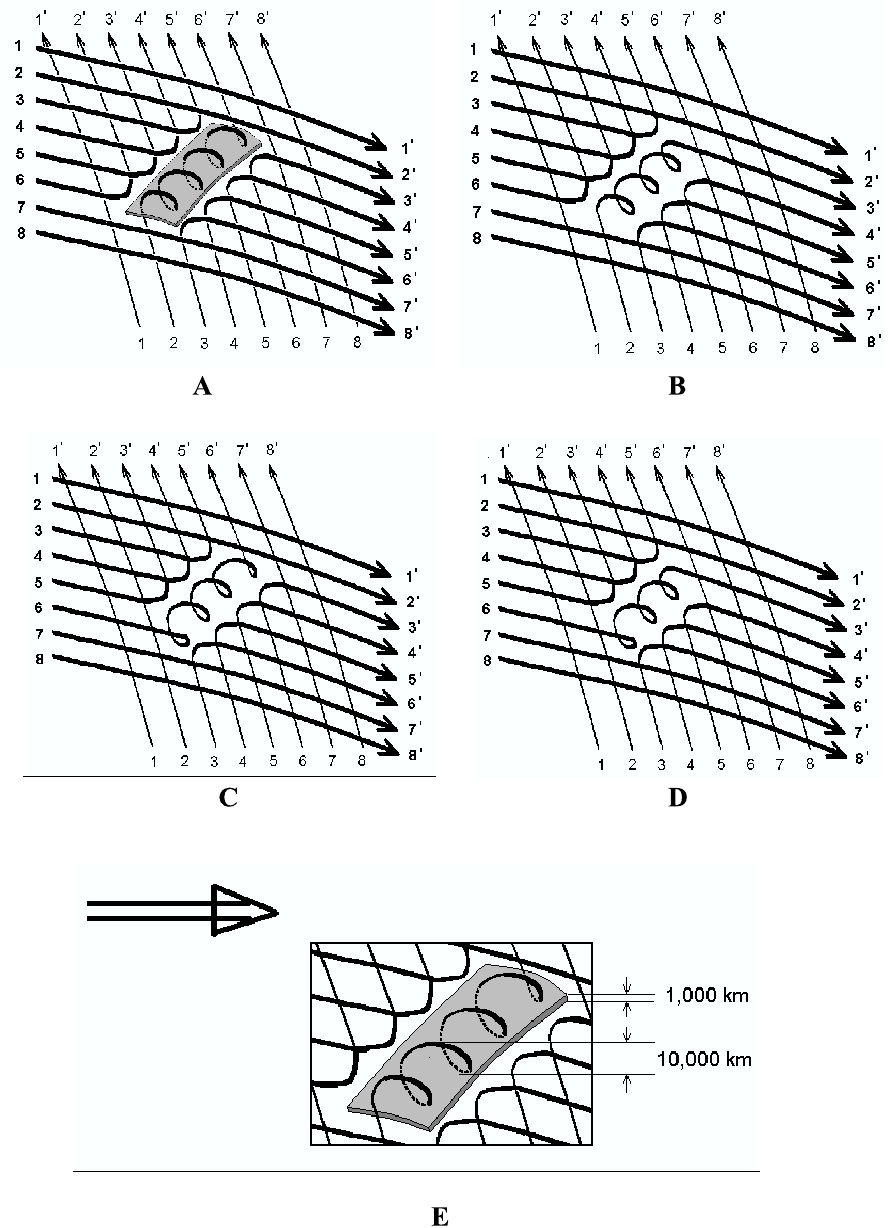
Fig. 16. Flux rope diagram partly adopted from computer simulations results (Lee et al., 1993). Thick lines indicate magnetosheath magnetic field lines that are located closer to the viewer, while thin lines indicate background magnetospheric field lines. Field lines are numbered to make viewing easier. Four cases are shown: both ends of the flux rope connected to the magnetosphere (A) , one end connected to the magnetosheath and another end connected to the magnetosphere (B) and (C) , and both ends connected to the magnetosheath (D) . The spatial relationship of magnetic field lines is most readily seen in drawing A. Thick lines show magnetic field line segments loaded with magnetosheath plasma, thin segments are loaded with magnetospheric plasma. Large arrow shows magnetosheath flow direction. Directions of magnetic fields and magnetosheath flow are close to conditions observed on 15 February 1996 and on 16 April 1996. Inset on the bottom shows how the flux rope relates to the magnetospheric current sheet and indicates their linear